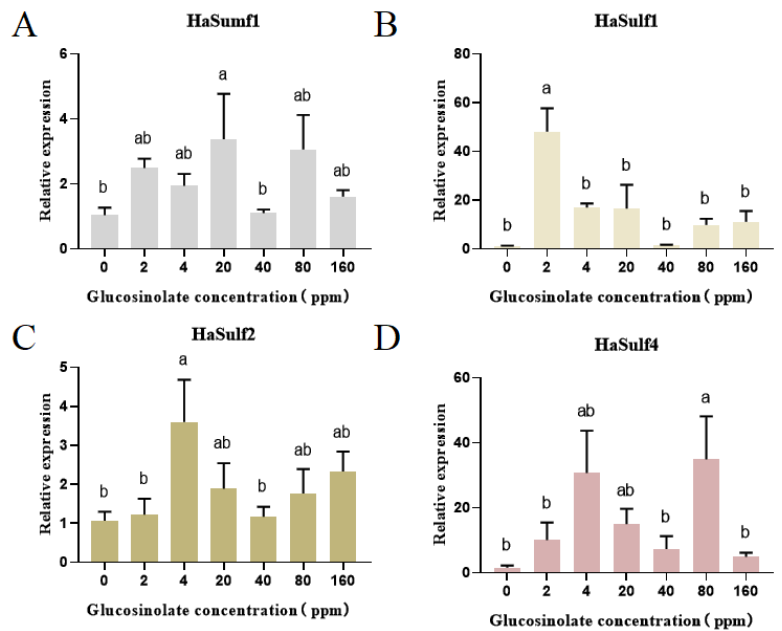
Figure 6. The effect of different concentrations of glucosinolate on the expression of HaSulfs gene family. The picture shows the expression level of HaSulfs gene family after feeding different concentrations of glucosinolate. ( A ) The relative gene expression of HaSumf1 . ( B ) The relative gene expression of HaSulf1 . ( C ) Relative gene expression of HaSulf2 . ( D ) The relative gene expression of HaSulf4 . Error bars indicate the standard error of the mean (SEM) ( n = 5). Lowercase letters indicate significant difference at p <0.05 (One-way ANOVA).